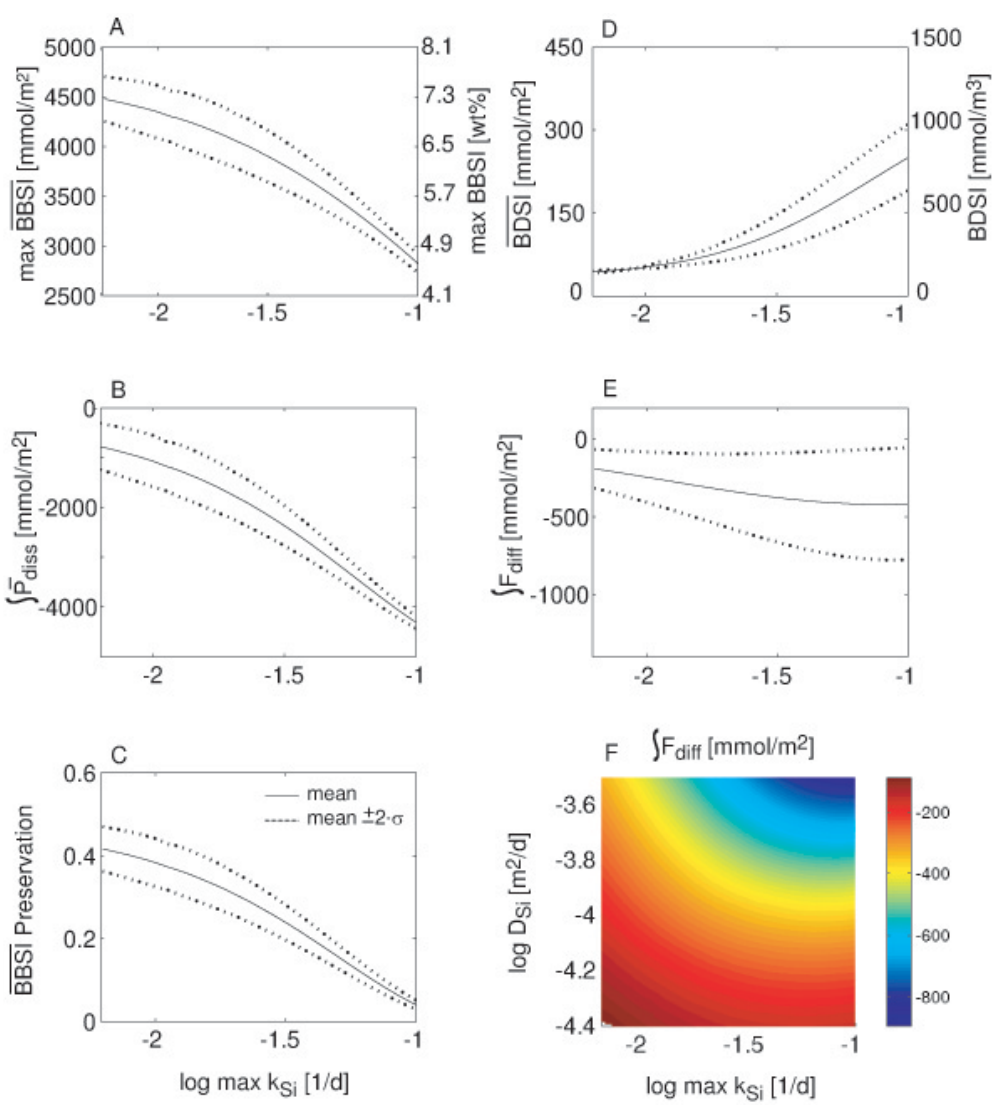
Fig. 4. Distribution of benthic variables and processes over the logarithm of maximum dissolution rate constants max k Si . (A) Annual maximum, depth-integrated biogenic silica contents maxBBSI (B) time- and depth integrated dissolution rates R P diss , (C) preservation of BBSI after one year of simulation, (D) average BDSI and depth-integrated BDSI dissolved silica concentration at the end of simulation and (E) time-integrated diffusive fluxes R F diff . (F) Distribution of time-integrated diffusive fluxes over maximum dissolution rates k Si and diffusion coefficients D Si . Shown are the results of 1000 model runs with randomly drawn parameter vectors (Table 2, Sensitivity experiment